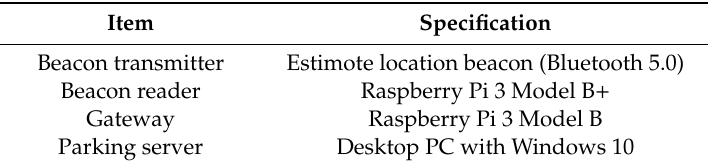
Table 2. List of equipment in the experiments.